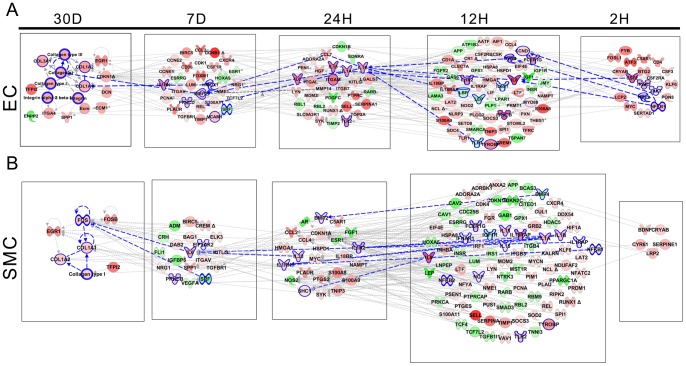
Backpropagation based interactive network analysis of the genes.
A) EC, B) SMC: A hierarchical network of interactive genes was developed consisting of differentially expressed genes from 30 D to 2 H. First level of the network was developed from the genes that are significantly differentially expressed at the final time-point (30 D). Second level of the network was built using differentially expressed upstream interactive genes at the prior time-point (7 D). This process was repeated until we reached the starting time-point of 2 H.